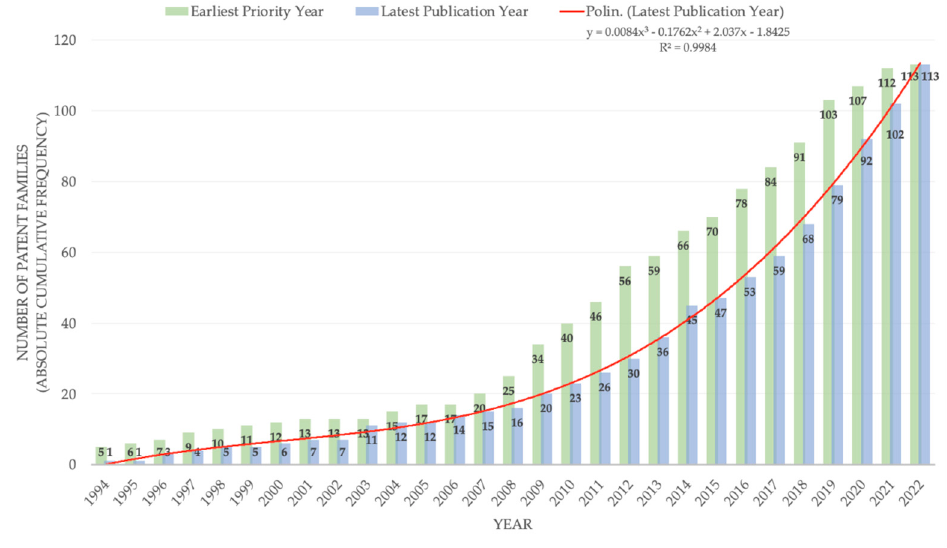
Figure 1. Temporal development trend of the innovation process.